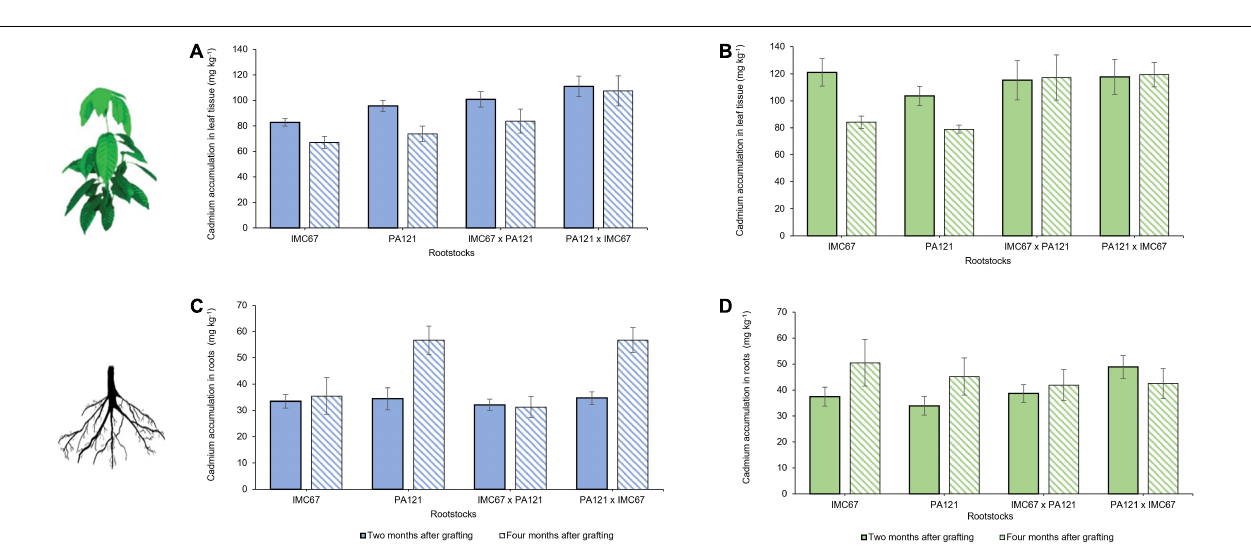
FIGURE 2 | Cadmium accumulation in rootstock × scion combinations 2 and 4 months after grafting. Seedling rootstocks families were established in soil enriched with Cd (7.49 mg Cd kg − 1 soil). Panels (A,C) depict cadmium accumulation in grafting combinations having ICS95 as scion. Panels (B,D) show Cd accumulation in grafting combinations having CCN51 as scion. Data are mean values ± SE ( n = 8).